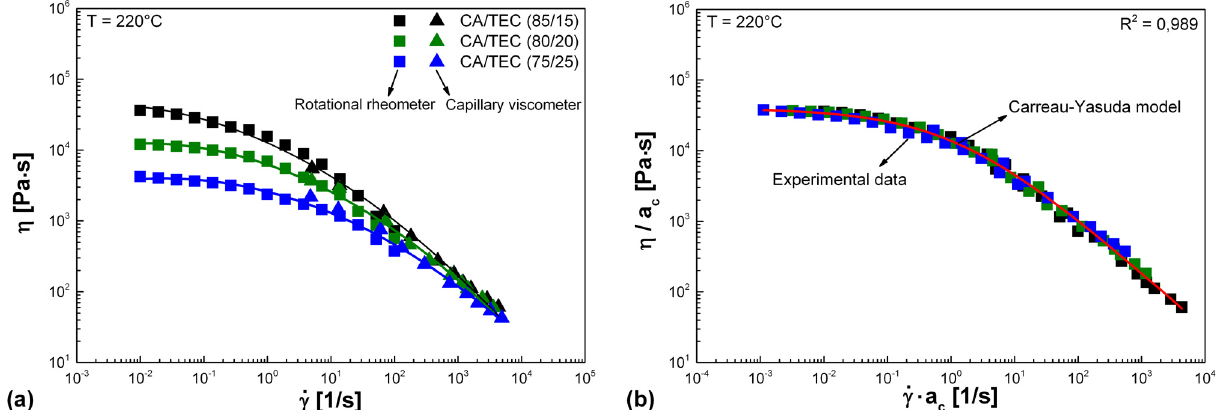
Figure 6. ( a ) Shear viscosity η of externally plasticized CA as a function of shear rate in dependence of TEC content; ( b ) Calculated master curve using a concentration-dependent and predicted master curve using the Carreau-Yasuda shift factor a c